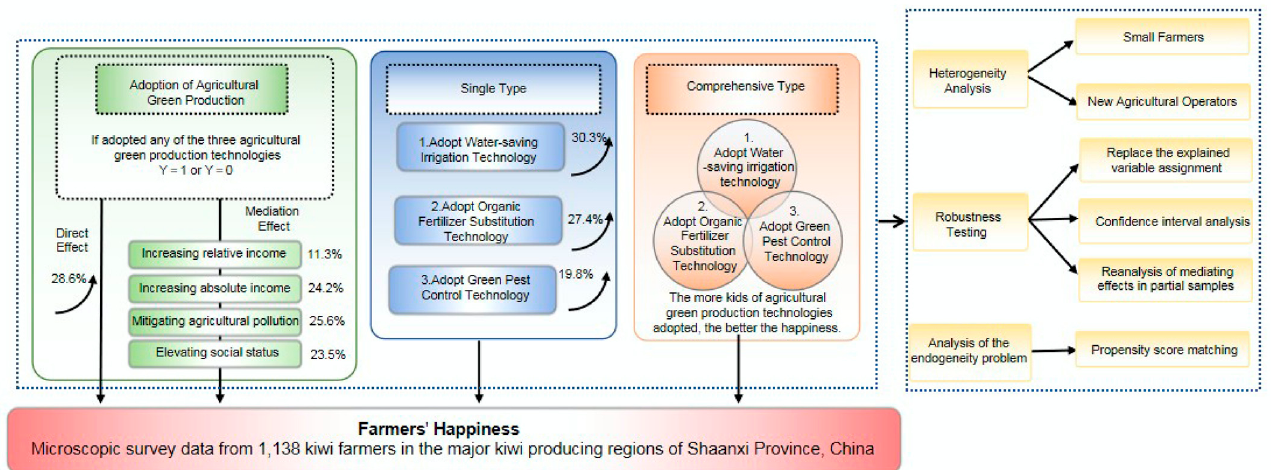
Figure 6. Findings of the manuscript.